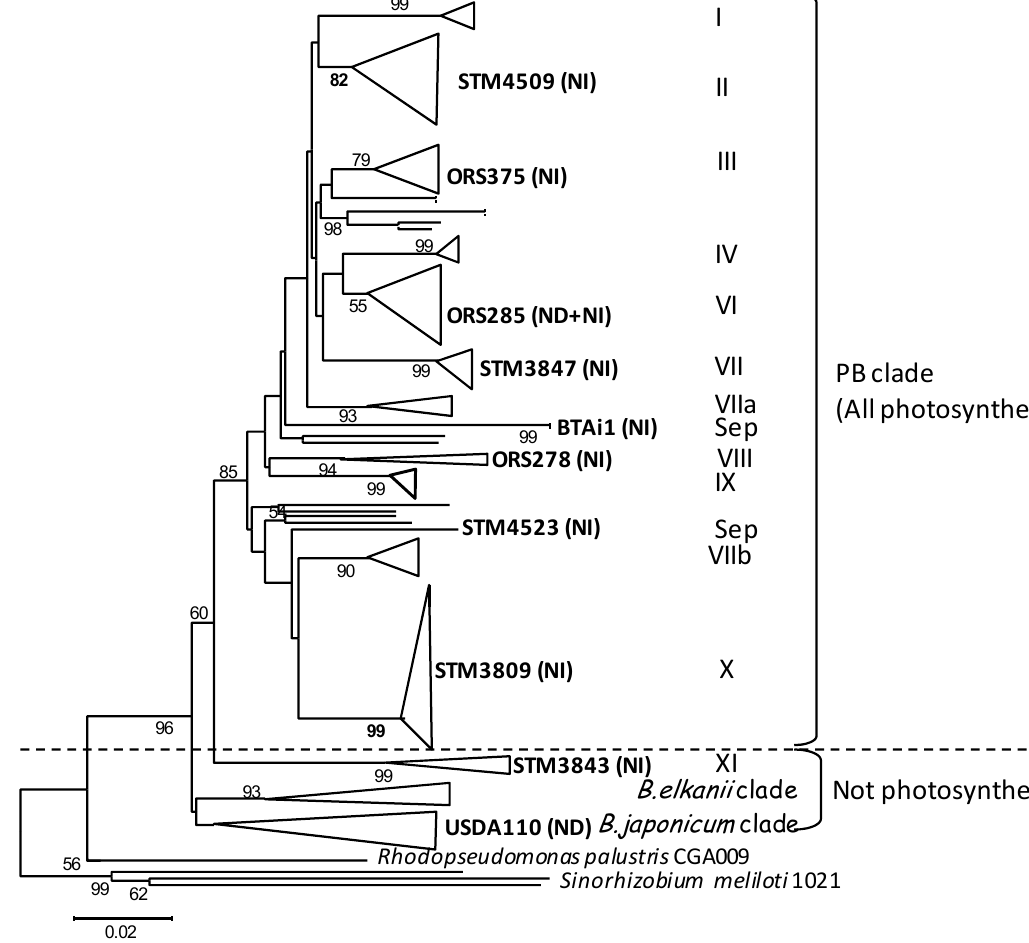
Figure 1. Maximum likelihood recA phylogeny of Aeschynomene bradyrhizobial symbionts indicating the position of genome-sequenced strains. Adapted from